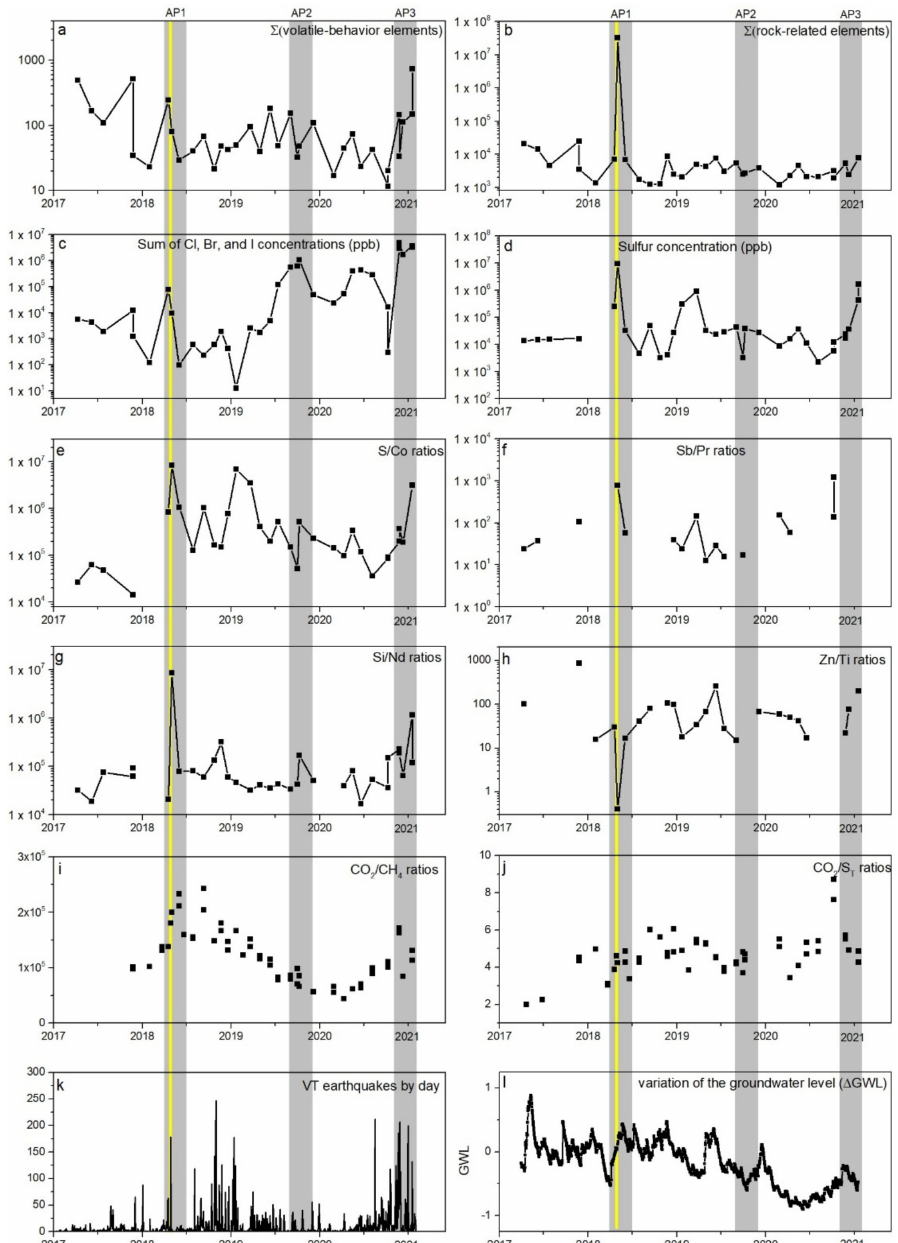
Figure 6. Time-series variations in major and trace elements in CS condensates linked to multipara- metric data from the volcanic system and the CS fumarole (taken from bulletins of the OVSG-IPGP). ( a – d ) Variations in the concentration (in ppb) of volatile-behavior elements (S, Sb, B, Cl, Bi, As, Zn, Mo, Br, Cd, Ag, Ni, I, Pb, Tl, Sn, and Cu), rock-related elements (Be, Na, Mg, Al, Si, P, K, Ca, Ti, Cr, Mn, Fe, Rb, Sr, Y, Zr, Cs, Ba, REEs, Th, and U), the amount of easily scrubbed or highly soluble elements (Cl, Br, I), and the amount of S. ( e – h ) Variations in the S/Co, Sb/Pr, Si/Nd, and Zn/Ti ratios from condensate samples. ( i , j ) CO 2 /CH 4 and CO 2 /S T ratios from soda bottles collected monthly by the OVSG-IPGP and previously published by Moretti et al. [11]. ( k ) Number of volcano-tectonic (VT) earthquakes by day during the study period. ( l ) Variations in the groundwater level ( ∆ GWL), which rapidly responds to changes in the input of meteoric waters into the La Soufriere hydrothermal system. Gray areas depict anomalous periods (APs) described in Section 4.2, while the yellow line shows the felt earthquake M L 4.1 on 27 April 2018. Missing plots correspond to concentrations below the detection limit or high RSD > 50% (Supplementary Material